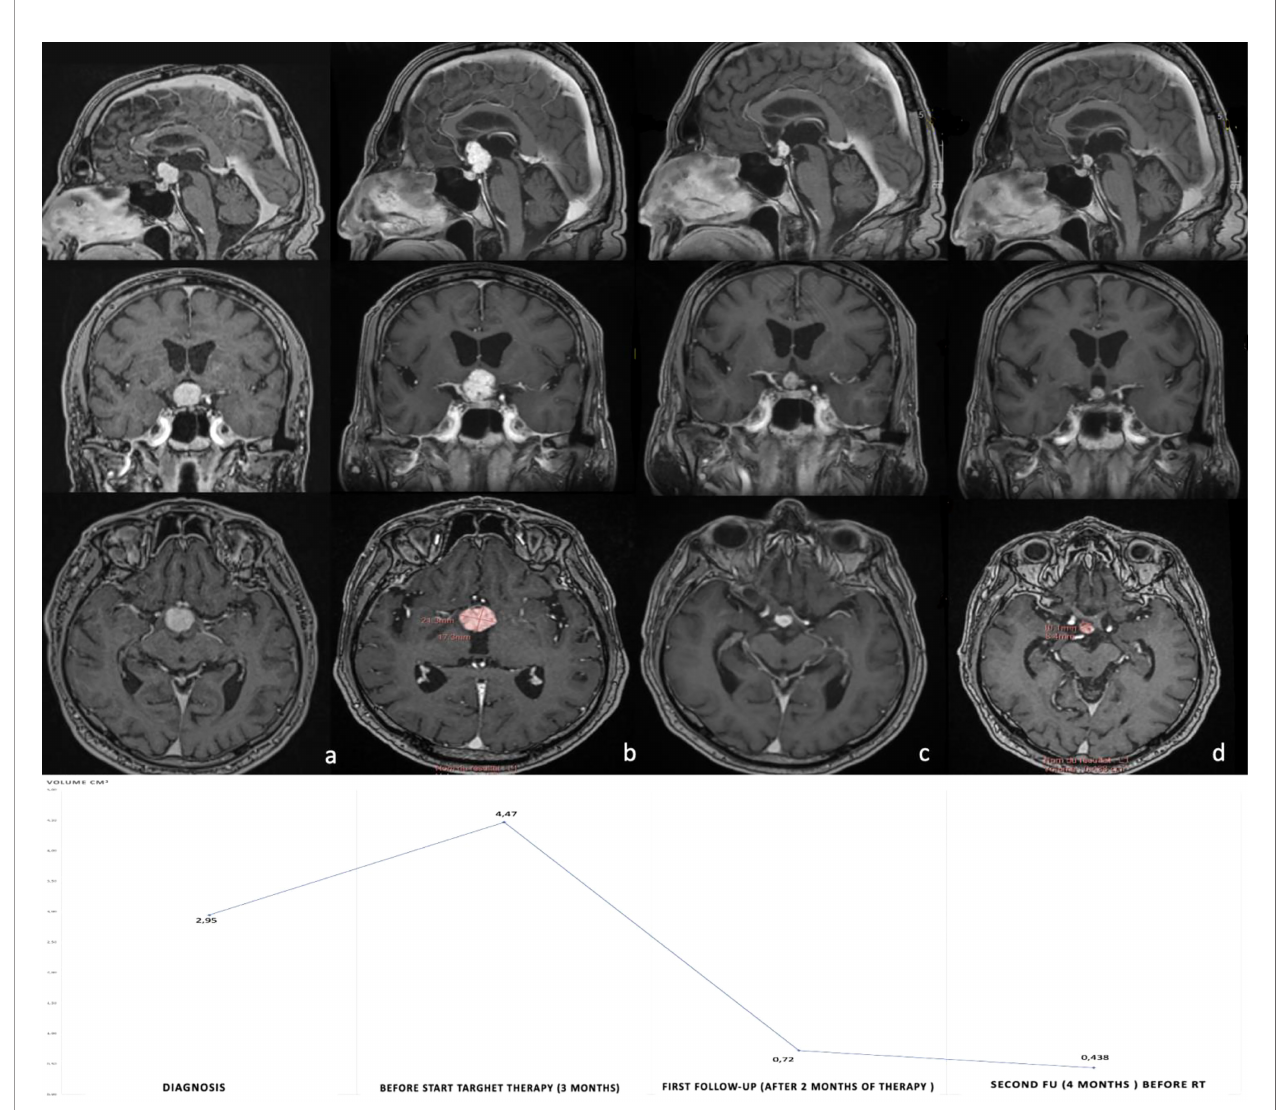
FIGURE 2 | Post-gadolinium axial, coronal and sagittal T1WI MRI images of case 2. (A) Postcontrast T1-weighted image shows large homogeneously enhanced intraventricular mass measuring 19 x 18.5 mm maximal axis and 2.945 cm 3 volume. (B) Shows progression of the intraventricular tumor portion after trans-ventricular endoscopic biopsy (18% of tumor volume). Panels c and d show a dramatic reduction in volume at 2 months (C) and 4 months (D) after commencing combined BRAF/ MEK inhibitor treatment. Note complete resolution of the mass effect on suprasellar neurovascular structures and on Monro ’ s foramen. Volume curve has been reported in the inferior part of fi gure. RT,